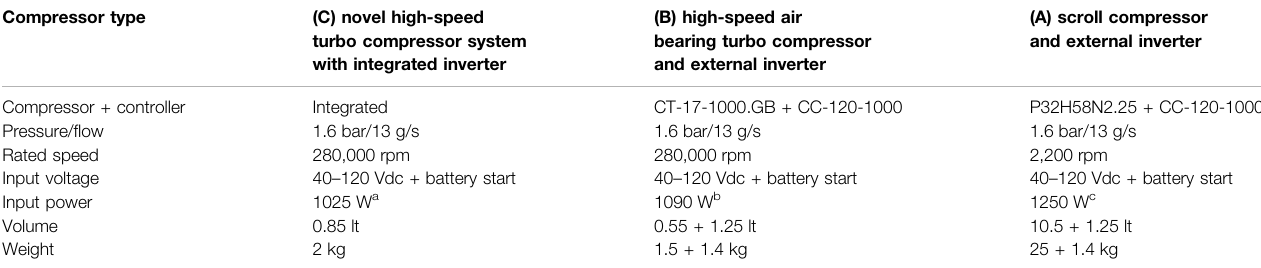
TABLE 1 | Performance comparison of (A) state-of-the-art fuel cell scroll compressor (P32H58N2.25 (Air Squared, 2015)) paired with external inverter (CC-120-1000), (B) high-speed air bearing turbo compressor (CT-17-1000.GB (Celeroton, 2017))paired withexternal inverter (CC-120-1000), and (C) novel high-speed turbo compressor system with integrated inverter described in this paper. The values given below are for a typical full-load operating point of a 10 kW fuel cell system. Compressor